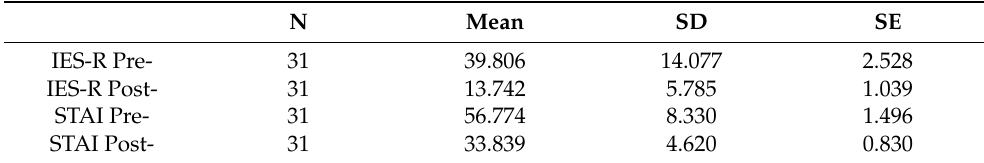
Table 5. Descriptive statistics of scores (pre- and